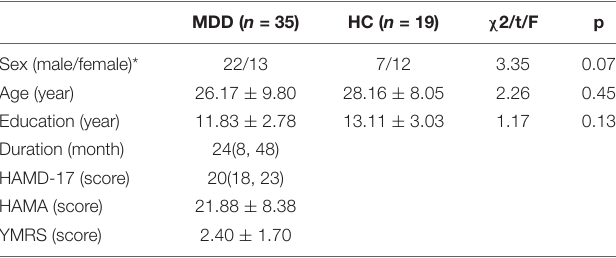
TABLE 1 | Comparison of general demographic data and clinical symptom scores (x ± s).